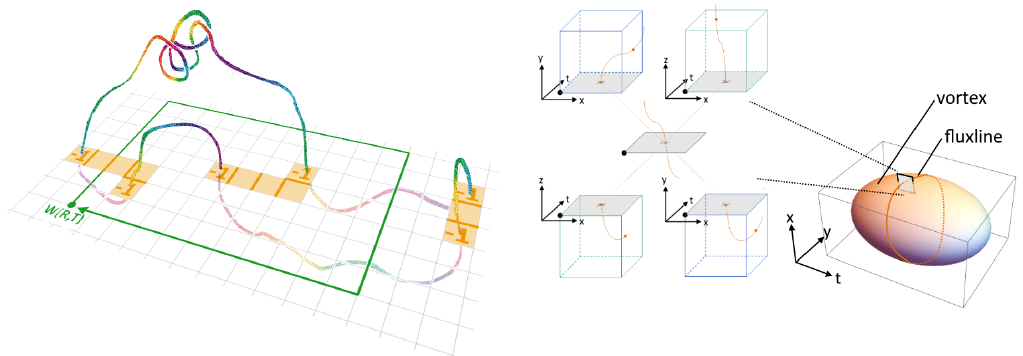
Figure 1. ( left ) After transformation to maximal center gauge and projection to the center degrees of freedom, a flux line can be traced by the following non-trivial plaquettes. ( right ) Due to the evolution in time, such a flux can be traced in two dimensions. In dual space, it results in a closed surface.